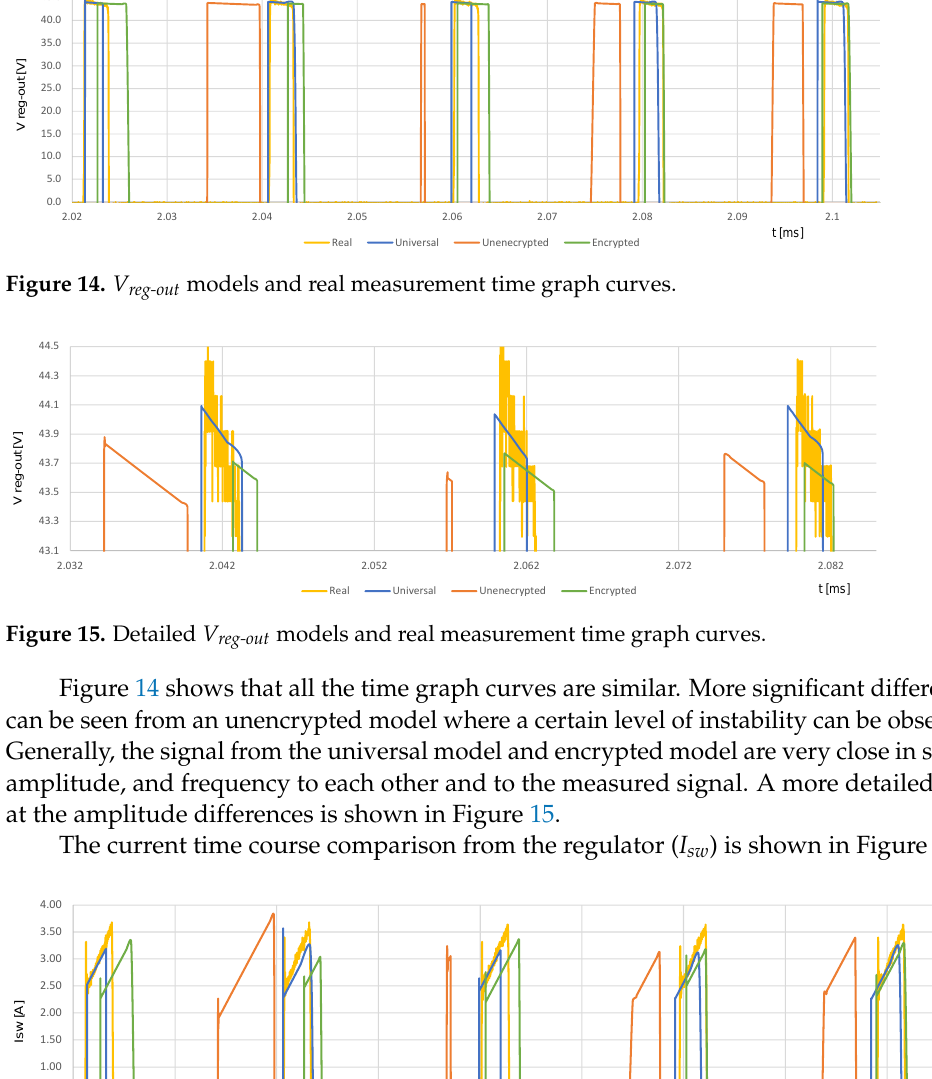
Figure 16. I sw models and real measurement time graph curves.